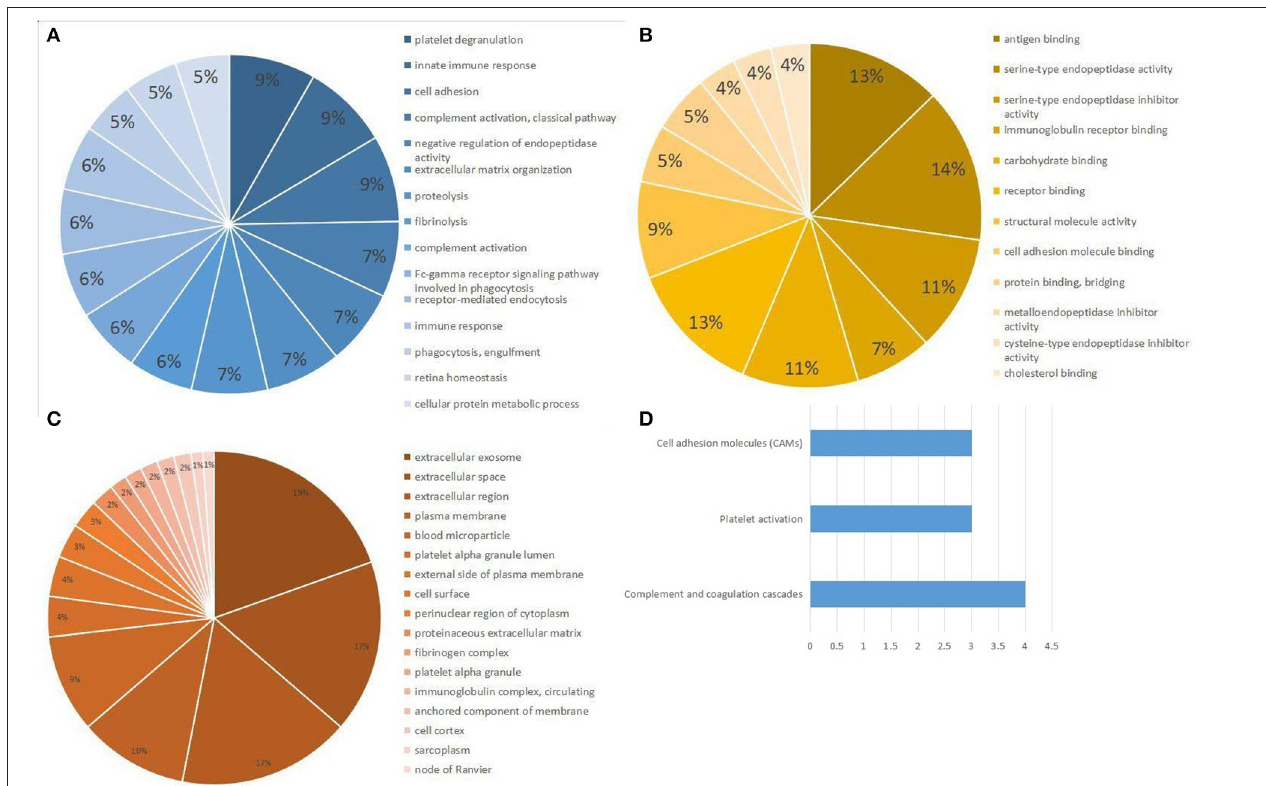
FIGURE 2 | Gene Ontology (GO) and KEGG pathway analysis of differential expression proteins. (A) Biological processes obtained from GO analysis of all differential expression proteins. (B) Molecular function obtained from GO analysis of all differential expression proteins. (C) Cellular component analysis from GO analysis of all differential expression proteins. (D) Top three pathways obtained from KEGG pathway analysis of all differential expression